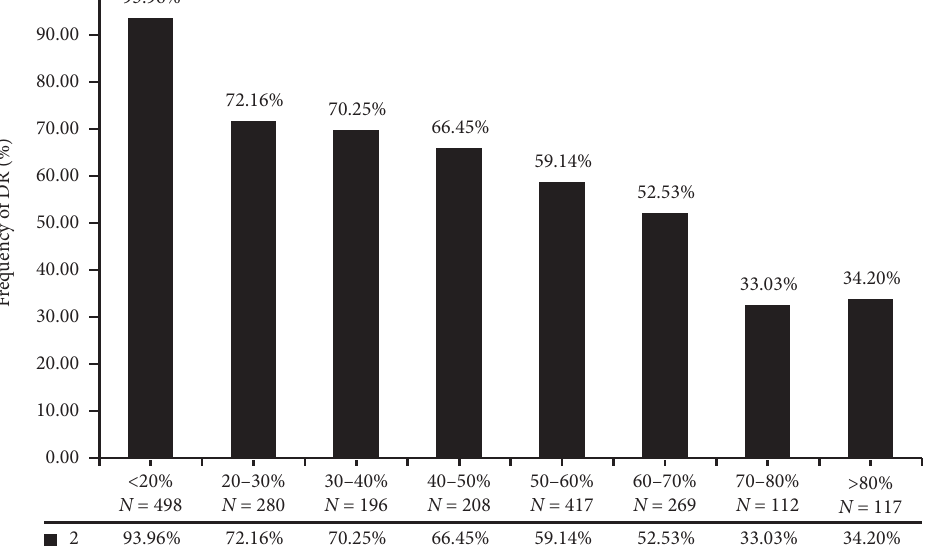
Figure 6: Distribution of DR with different TIR.